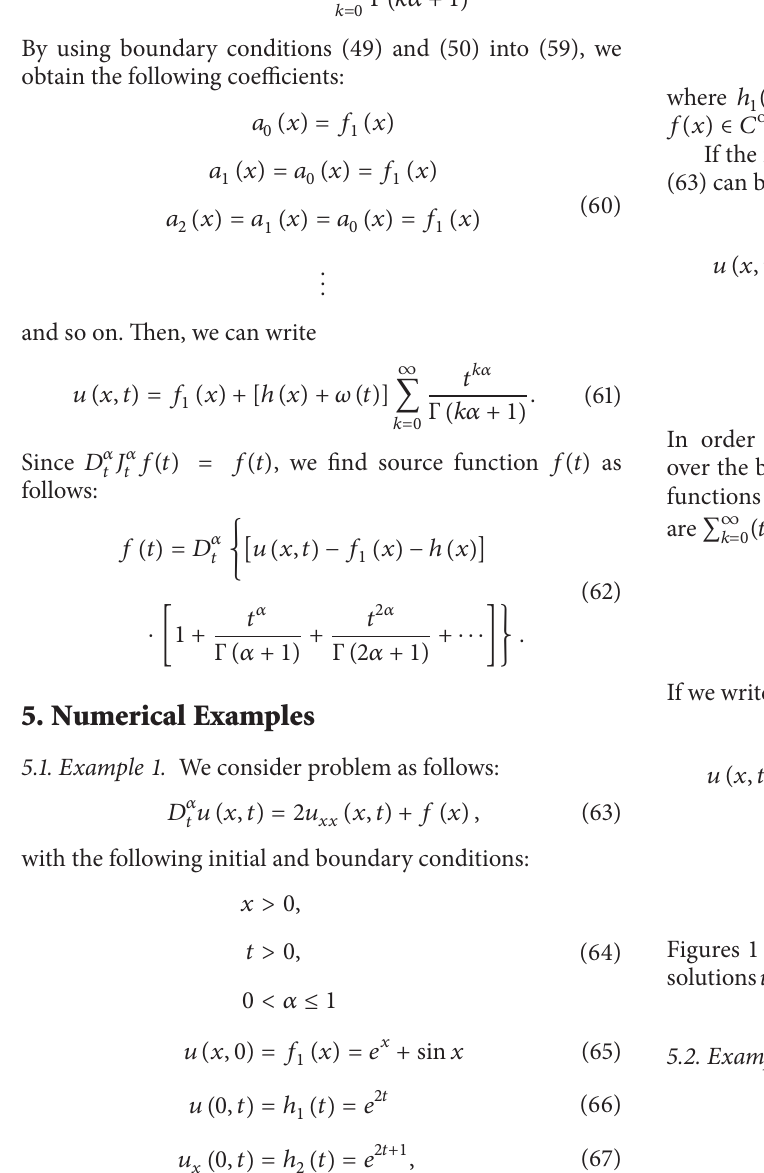
Figure 1: 𝑢(𝑥,𝑡) values for source function 𝑓(𝑥) at 𝛼 = 1/2 value.